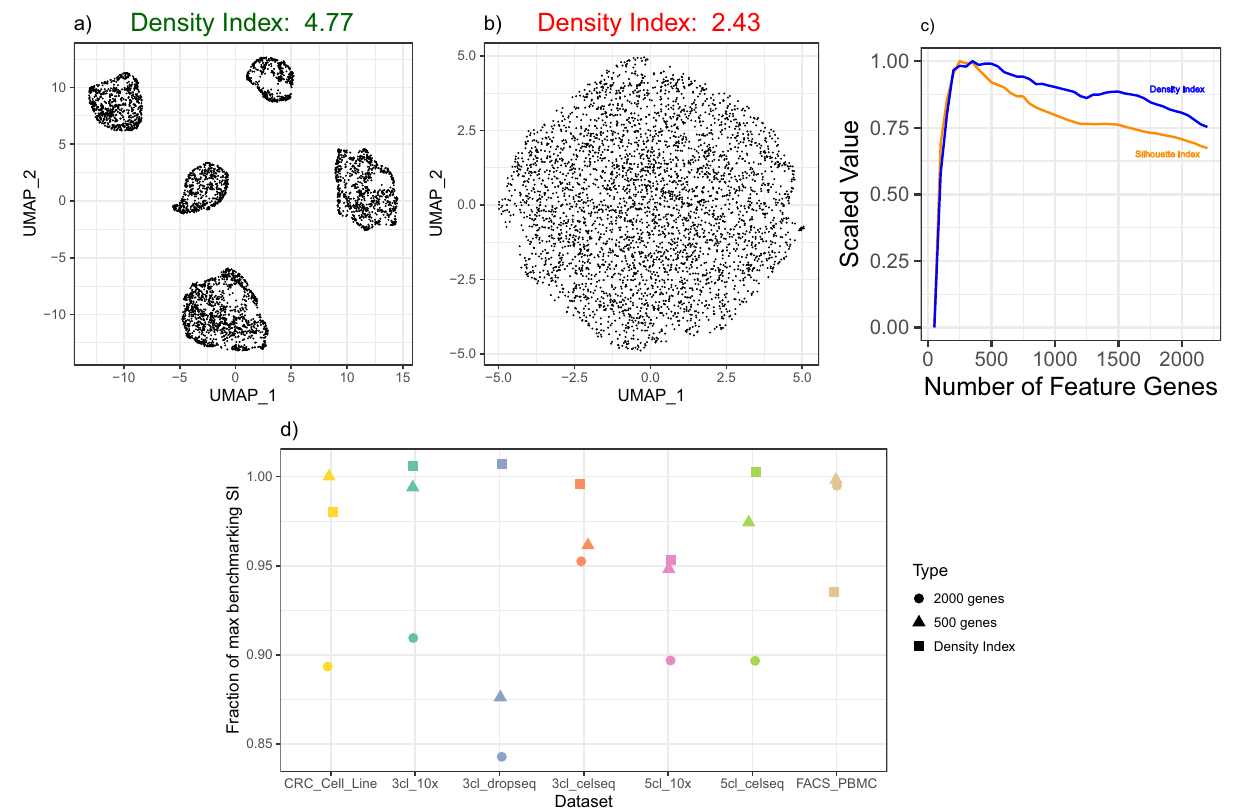
Fig. 5 The density index. a , b UMAP visualizations of the 5 cell lines comparing the local neighborhood density of feature spaces in ( a ) good feature selection versus ( b ) poor feature selection. c Comparison of optimal density index and silhouette index over feature set size range. d Fraction of the maximum benchmarking SI achieved using feature set sizes determined by the density index as compared to fi xing feature set sizes at 500 genes and 2000 genes (refer to Supp. Table S6 for details regarding the datasets).